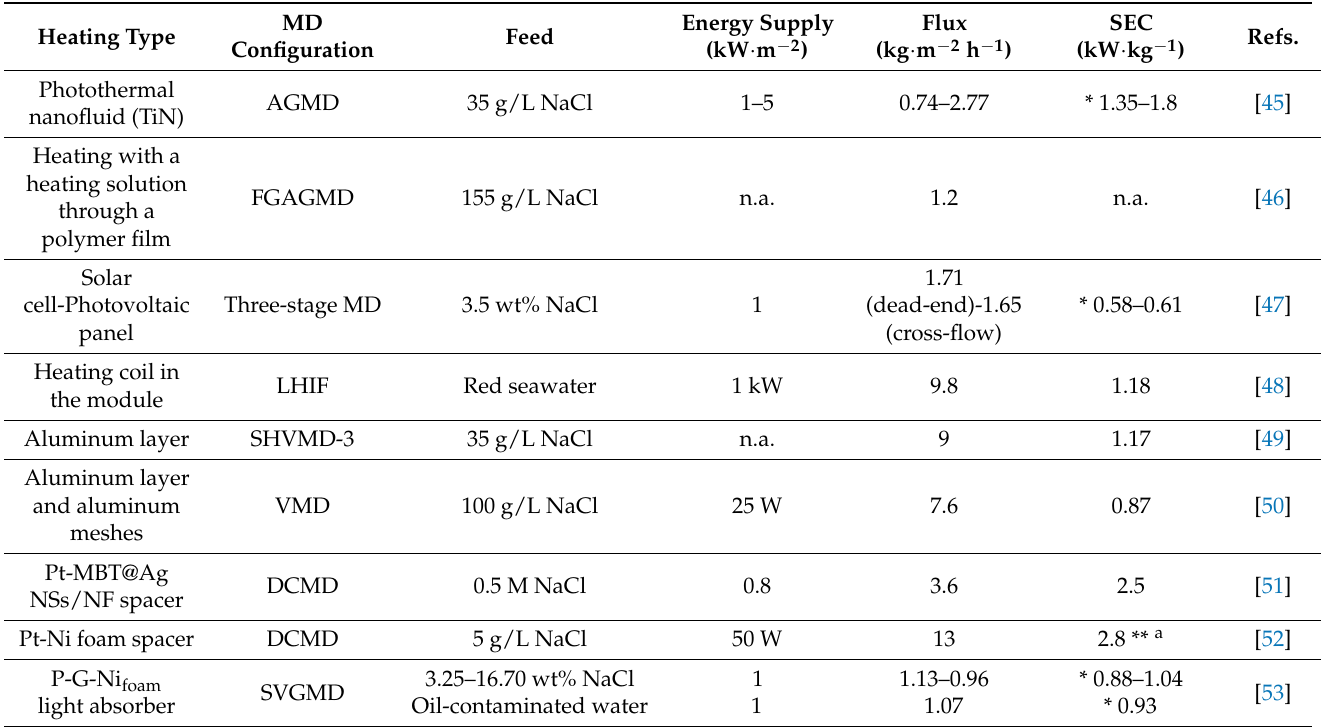
Table 3. Localized heating inside the modules (best